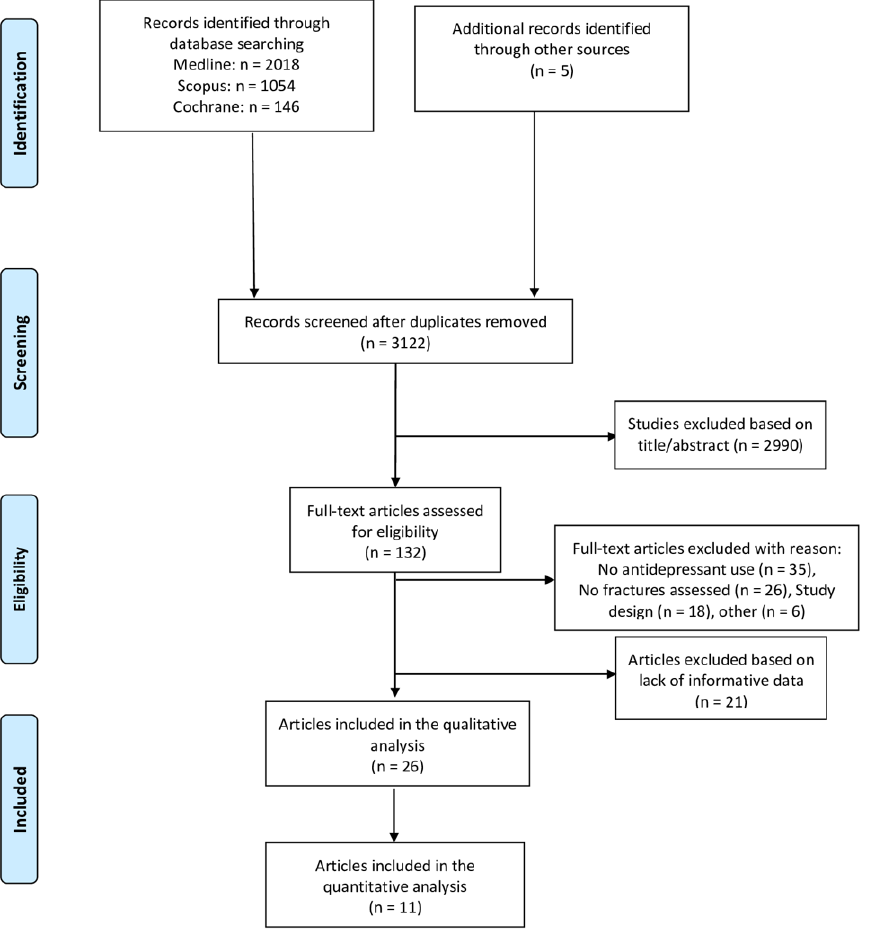
Figure 1. PRISMA Flow-chart.